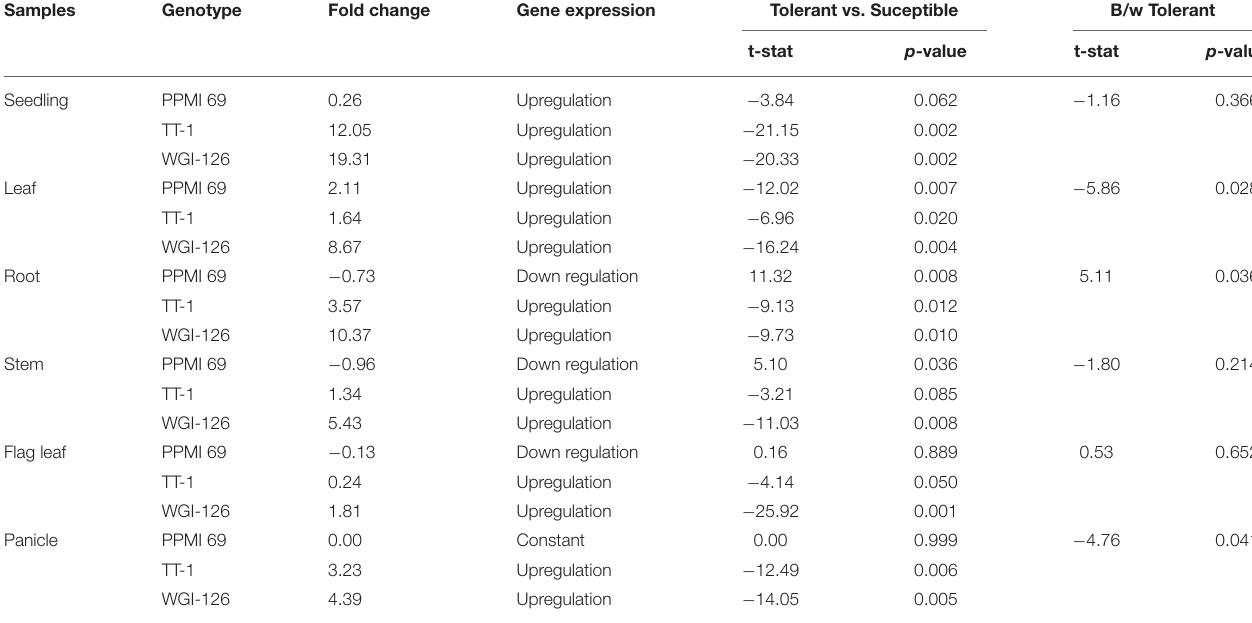
TABLE 6 | Comparison of the relative gene expression level of PgHSP16.97 at different tissues among the contrasting pearl millet genotypes under heat stress treatment.